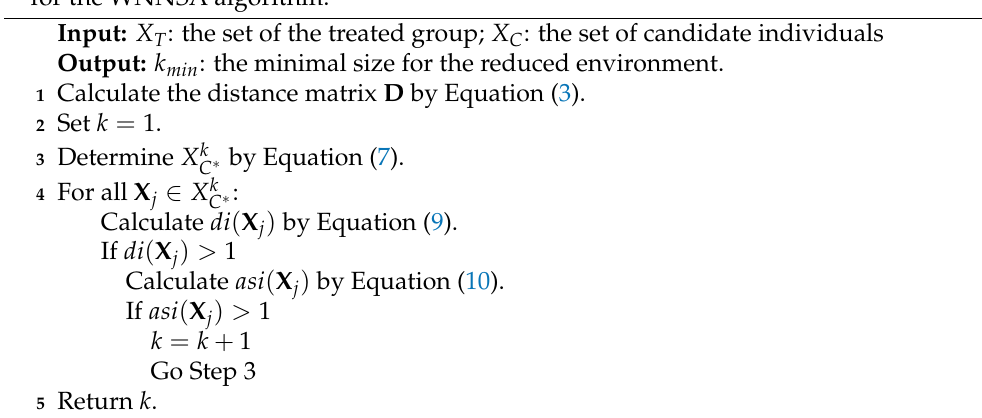
Algorithm 2: Determination of the minimal size for the reduced environment for the WNNSA